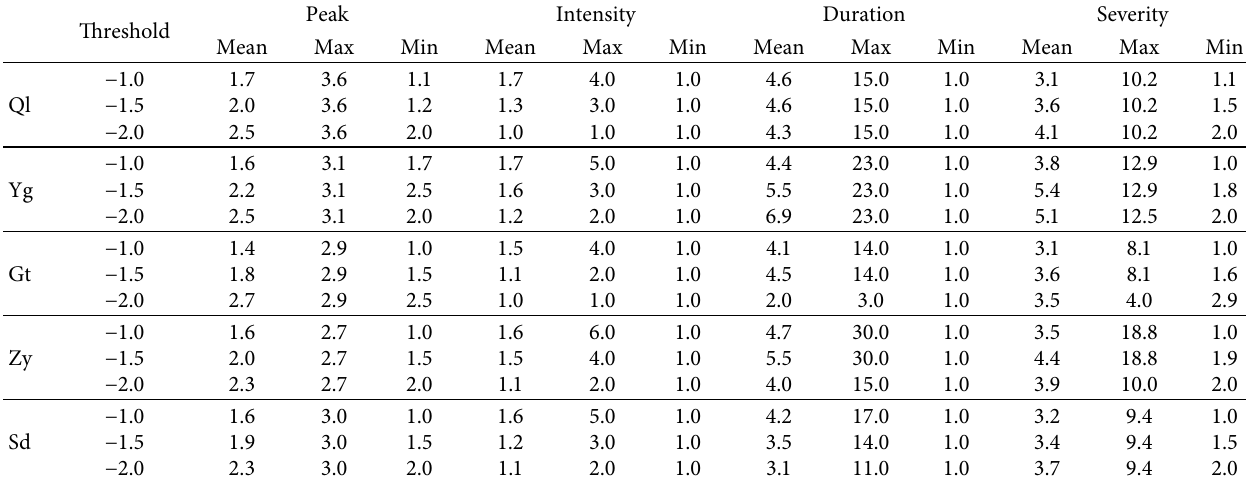
Table 4: The distribution peak, intensity, duration, and severity for MD characteristics based on SPI-1 using thresholds of − 1, − 1.5, and − 2 in the UHRB and MHRB. Peak Intensity Duration Severity Threshold